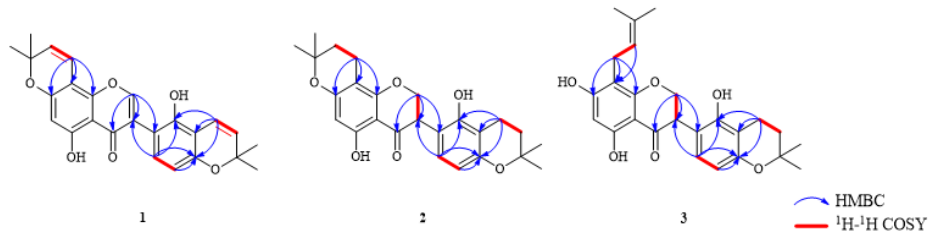
Figure 2. Key HMBC and 1 H- 1 H COSY correlations for compounds 1 – 3 .